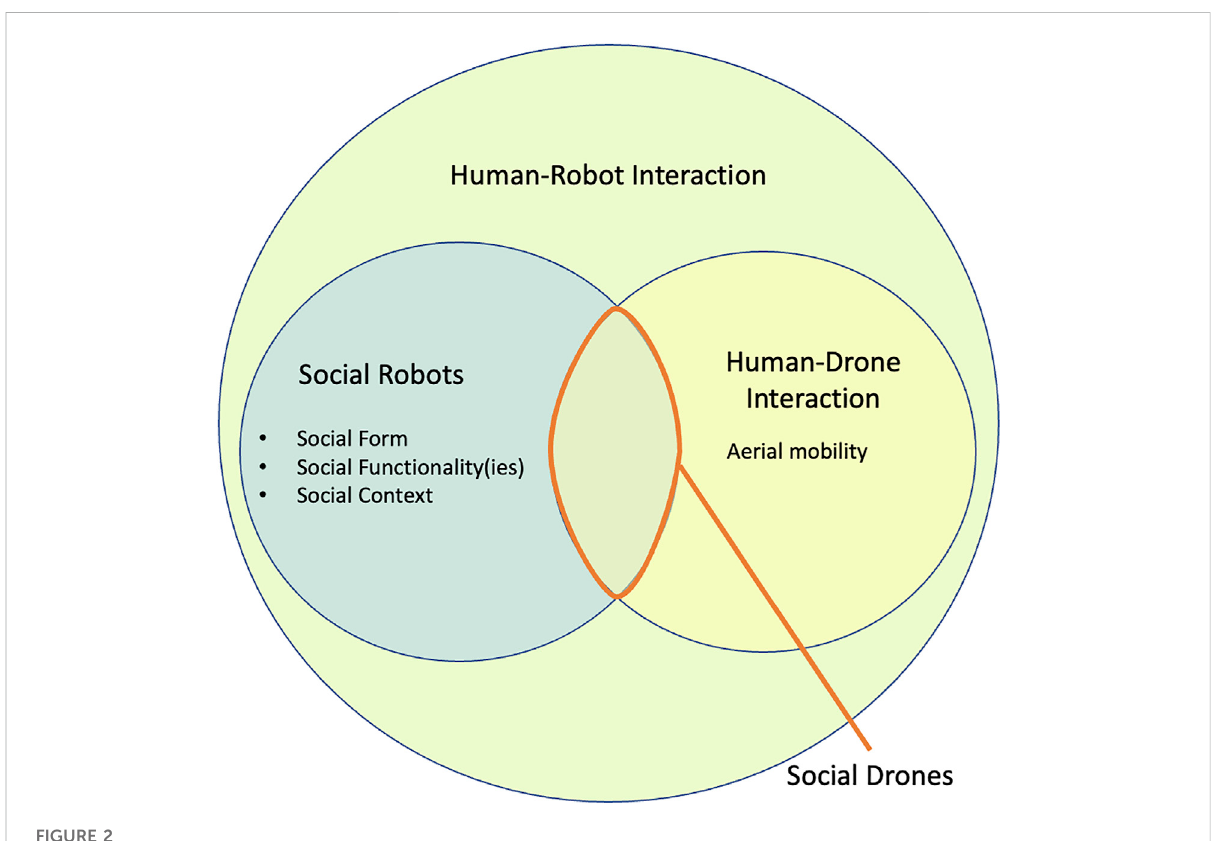
FIGURE 2 Overview of the research areas linked with social